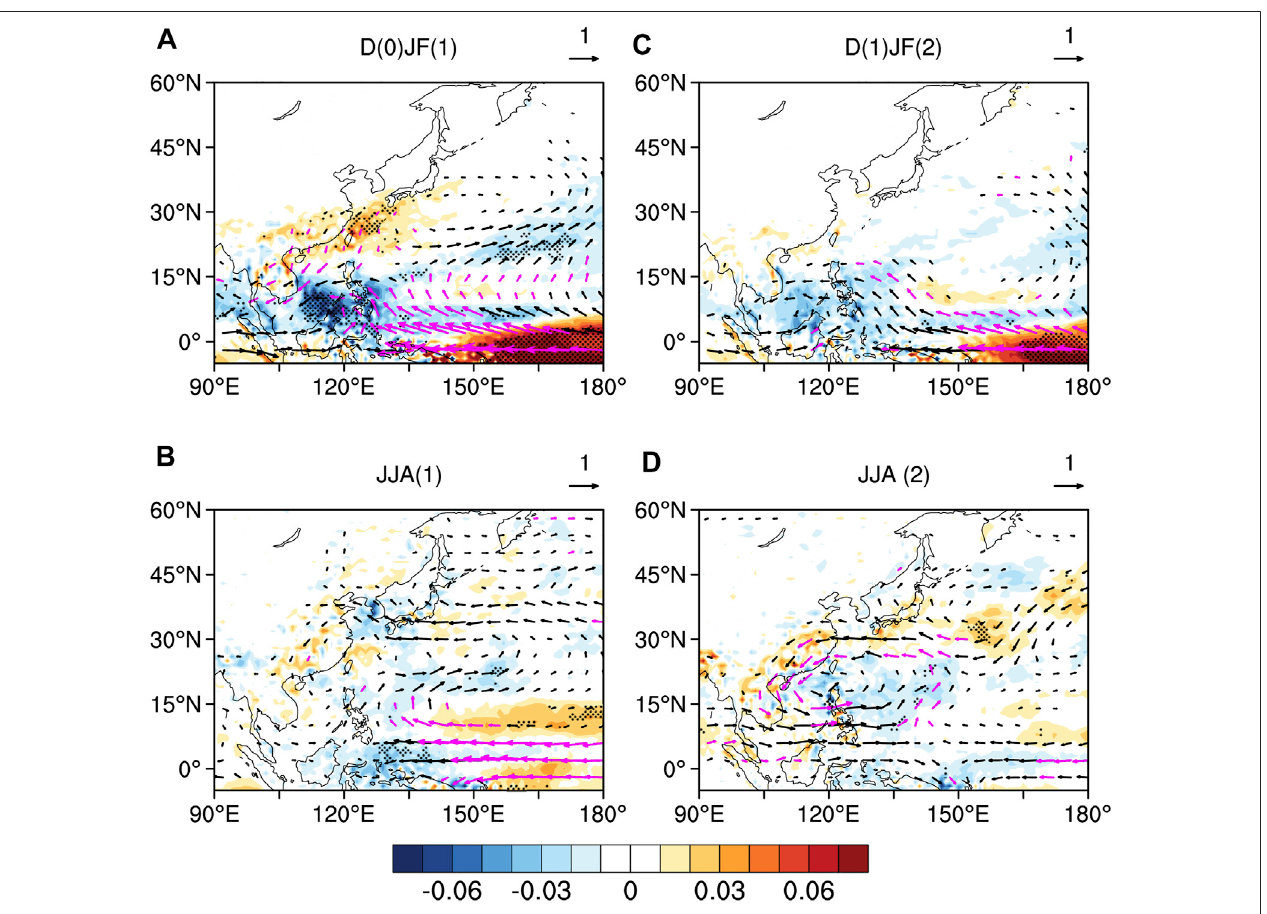
FIGURE6| CompositesofanomalousVIMFs(vector, units:10 − 5 g m − 1 s − 1 )andtheirdivergence(shaded,units:10 − 5 g m − 2 s − 1 )during (A) D(0)JF(1), (B) JJA(1), (C) D (1) JF (2), and (D) JJA (2). Dotted areas and purple vectors indicate values exceeding the 90% con fi dence level determined using a two-tailed Student ’ s t